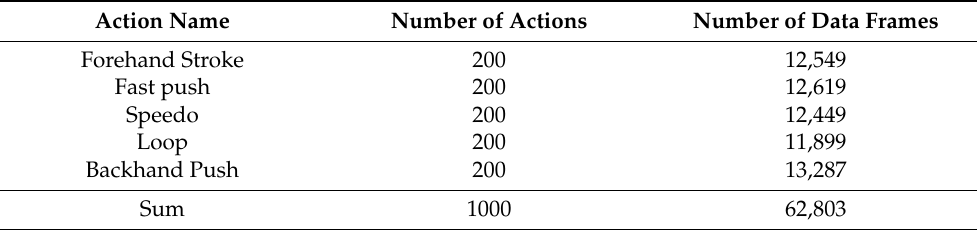
Table 3. Collecting data table of five table tennis hitting